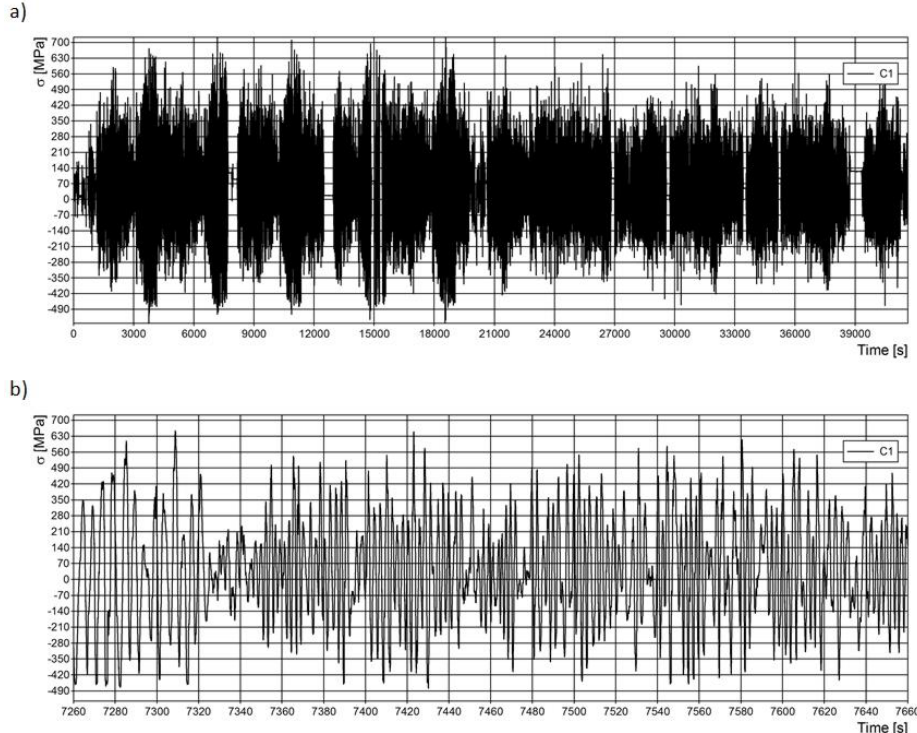
Figure 7. Stress curves in point C 1: ( a ) whole curve; ( b ) enlarged curve—400 s of measurement.